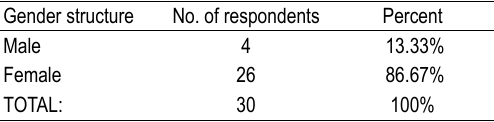
Table 1. Precision of hscrP